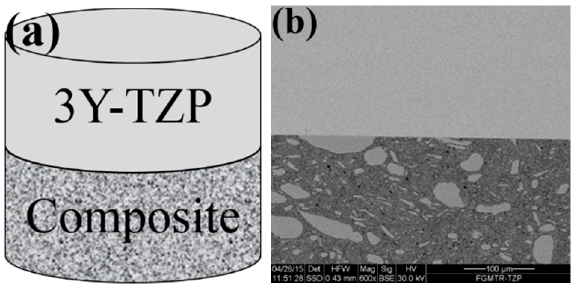
Figure 4. Joining a sintered composite (80 vol % ceramic) to a sintered TZP sample: ( a ) illustration; ( b ) SEM image of the bonding interface (the upper part is the (3Y)-TZP). A typical microstructure of the (3Y)-TZP layer after joining for 120 min at 1150 °C is shown in Figure 5.